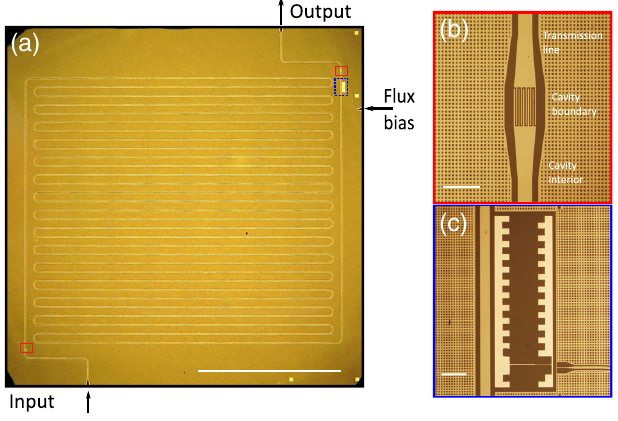
FIG. 1. Device for achieving MMSC. (a) A low fundamental frequency ω 0 = 2 π ∼ 92 MHz is realized by fabricating a meander- ing 0.68-m coplanar waveguide resonator on a 25 × 25 -mm sapphire substrate. The capacitive coupling at the input and output ports allows coupling of radiation into and out of the = 2 π ∼ 0 . 5 − 3 MHz. Red rectangles show resonator, at rates κ m coupling capacitors. The blue rectangle encloses the qubit. (b) Symmetric interdigitated capacitors define the cavity boun- daries and couple radiation to the transmission lines. (c) A transmon qubit is capacitively coupled to the center pin near the output capacitor, an antinode for all modes. Superconducting quantum interference device geometry allows for tuning qubit frequency ω via the flux bias line (shown) or the external magnet a [24]. The gridlike pattern in the ground plane pins flux